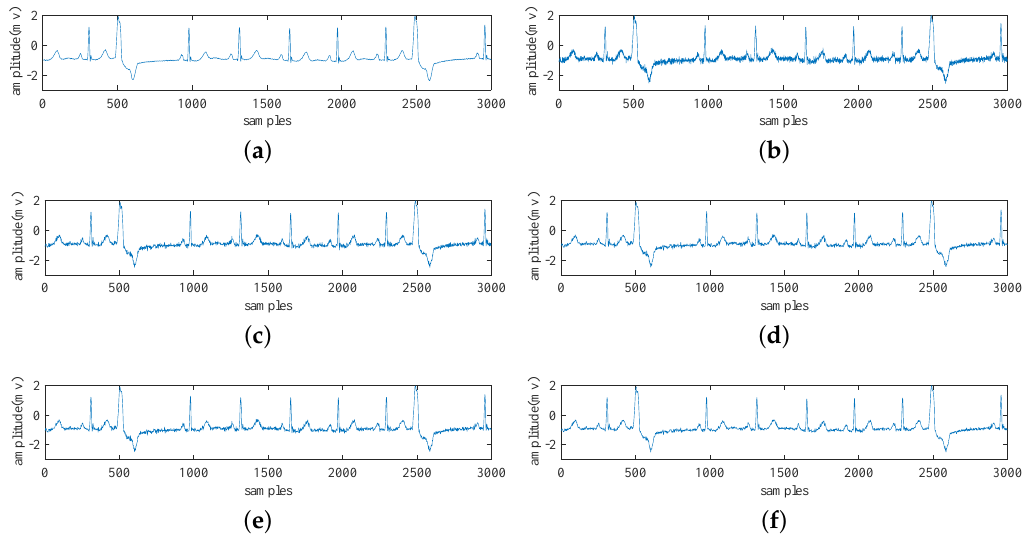
Figure 4. The de-noising results of adding 20 dB WGN to No. 119 record of the MIT-BIH database: ( a ) The original signal. ( b ) The signal after adding 20 dB WGN. ( c – f ) De-noised signals using wavelet soft threshold, EMD, EMD soft threshold, proposed